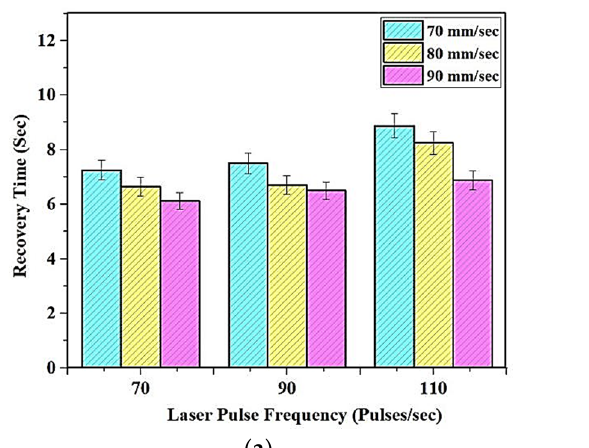
Figure 7. Strain Recovery testing with recovery time and temperature of sample for print speed of 70 mm/s and pulse frequency of 70 pulse/s.